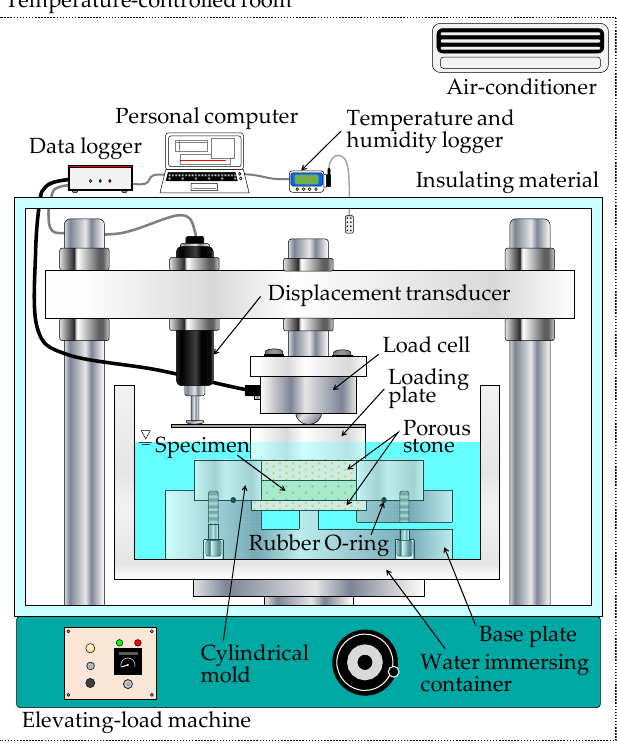
Figure 4. Schematic of the experimental configuration (modified version of the experimental setup in